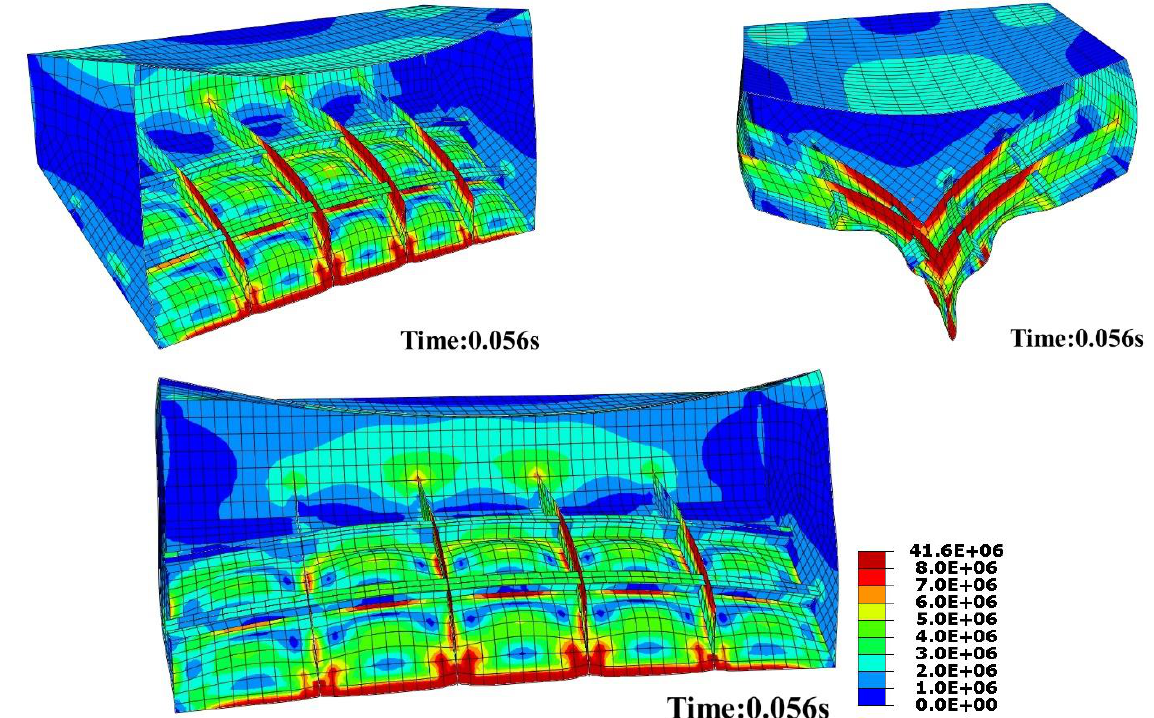
Figure 24. Structural deformation of grillage structure (in MPa; deformation enlarged 1200 times).